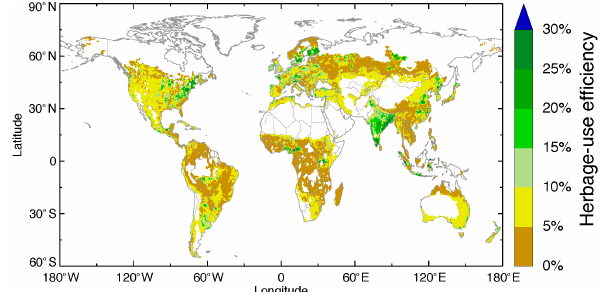
Figure 3. Average herbage-use efficiency over managed grassland (grazed plus mown) in 2000–2009 simulated by ORCHIDEE-GM v3.1. Herbage-use efficiency (Hodgson, 1979) is defined as the for- age removed expressed as a proportion of herbage growth. In this study, the forage removed is modelled annual grass-biomass use in- cluding Y grazed and Y mown , and herbage growth is modelled annual grass